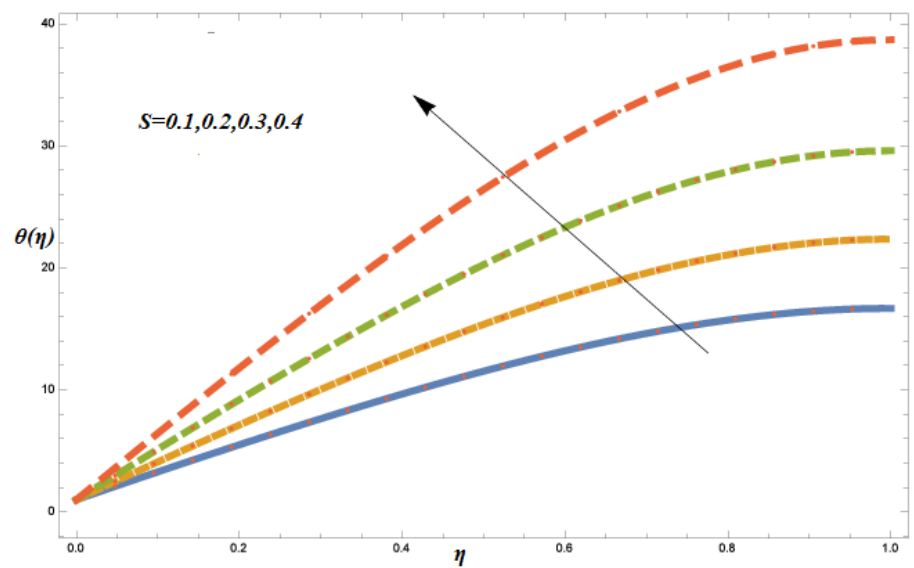
Figure 8. The variation of temperature scale gradient θ ( η ) for different quantities of S , when (cid:125) = − 0.25, P r = 10, B r = 0.7, N r = 0.7, D u = 0.7, S c = 0.7, ε = 0.7, S r = 0.7, λ = 0.7, Λ = 0.7, β = 1.